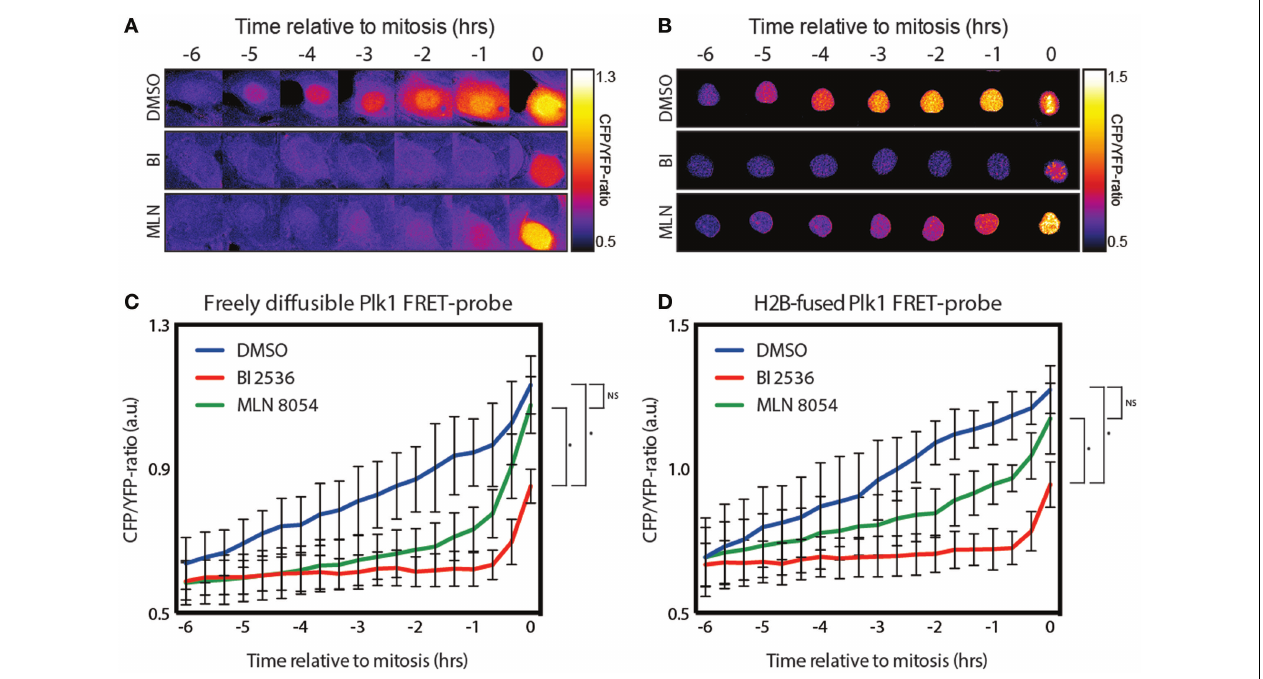
movie showing false color-coded CFP/YFP emission ratios of U2OS cells expressing the H2B-tagged FRET based biosensor were treated as in (A) . (C) Quantification of CFP/YFP-ratio of cells shown in (A) . Error bars represent the SD of 10 individual cells. (D) Quantification of CFP/YFP-ratio of cells shown in (B) . Error bars represent the SD of 10 individual cells; * p <